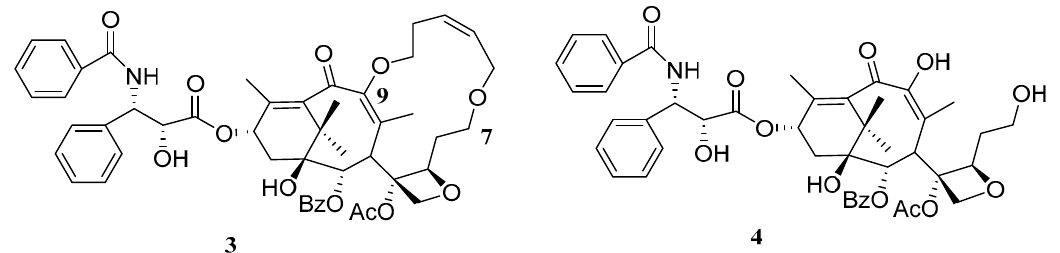
Figure 2. Structures of the 7,9- O -linked C-seco taxoid 3 and C-seco paclitaxel derivative 4 .